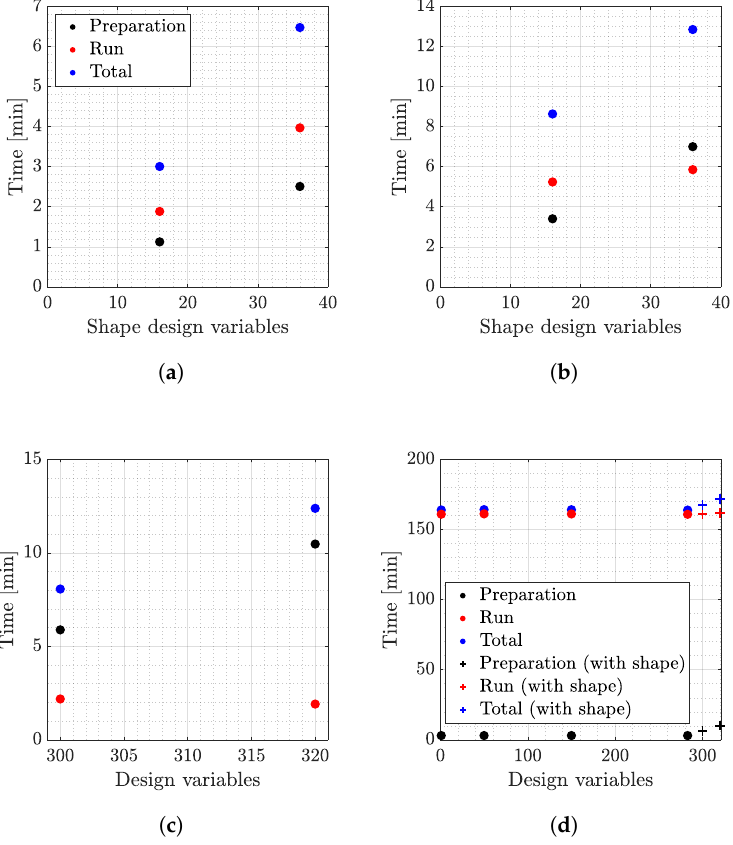
Figure 7. Mean case preparation and run times (wall-clock) as a function of shape design variables. The adjoint-based analyses (Subplots ( b – d )) include one forward and three adjoint solves. ( a ) Low- fidelity rigid; ( b ) High-fidelity rigid; ( c ) Low-fidelity aeroelastic; ( d ) High-fidelity aeroelastic. For the LF rigid model, both the preparation and run times scaled linearly with the number of design variables, since the derivatives were computed with finite